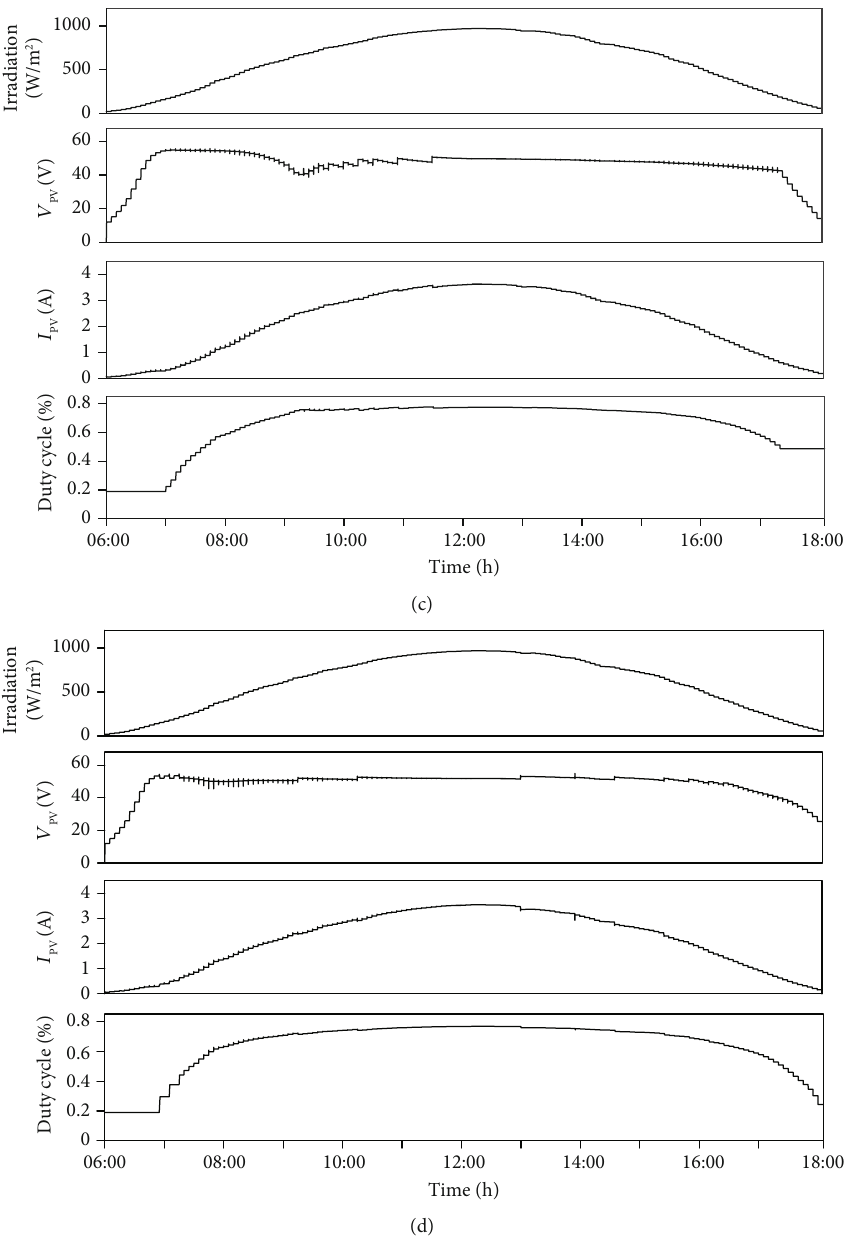
Figure 13: Simulation results of the INC, VSSINC, MINC, and the proposed technique for the one-day irradiance pro fi le: (a) INC; (b) VSSINC; (c) MINC; (d) the proposed